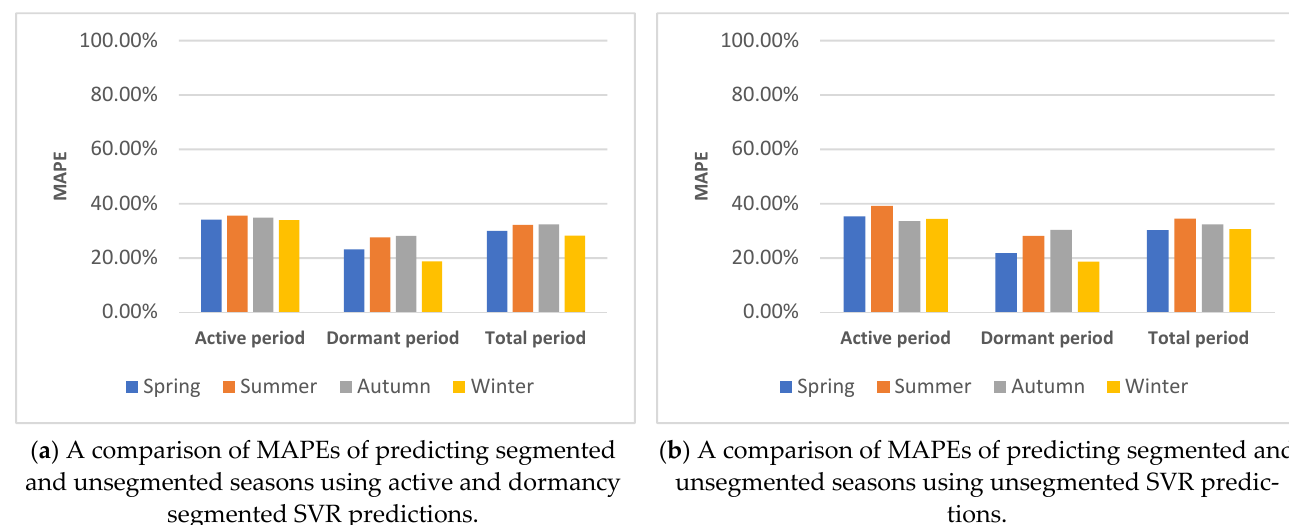
( b ) A comparison of MAPEs of predicting segmented and unsegmented seasons using unsegmented SVR predic- tions. Figure 18. A comparison of building active and dormant segmented and non-segmented SVR predictions’ MAPEs.